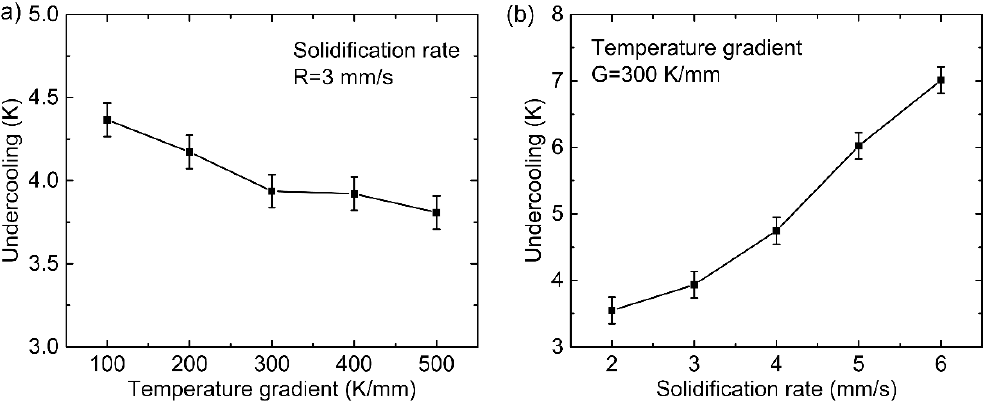
Figure 7. Maximum undercooling in the liquid ahead of solidification front with varying ( a ) tem- perature gradients and ( b ) solidification rates.